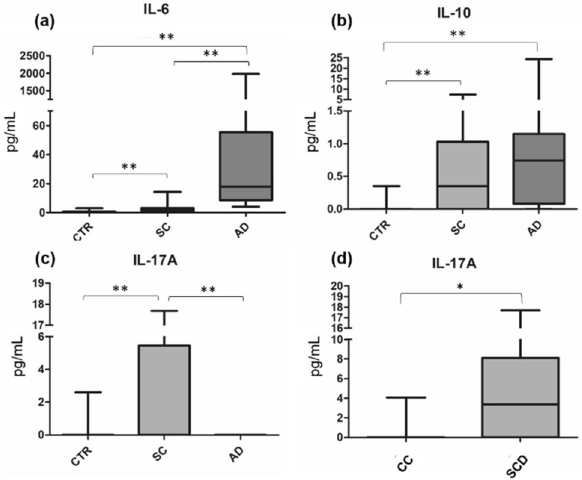
Figure 3. IL-6, IL-10 and IL-17A plasma levels in healthy controls, stable cirrhosis and in acute decompensation of cirrhosis. Plasma levels of IL-6 ( a ), IL-10 ( b ) and IL-17A ( c ) in healthy controls, stable cirrhosis and in acute decompensation of cirrhosis. Panel d: comparison between patients with compensated cirrhosis (CC) and patients with stable cirrhosis that had already developed decompensated cirrhosis (SCD). * p ≤ 0.05; ** p ≤ 0.01. AD Acute decompensation of cirrhosis, CTR Healthy controls, IL Interleukine. Differences were tested using